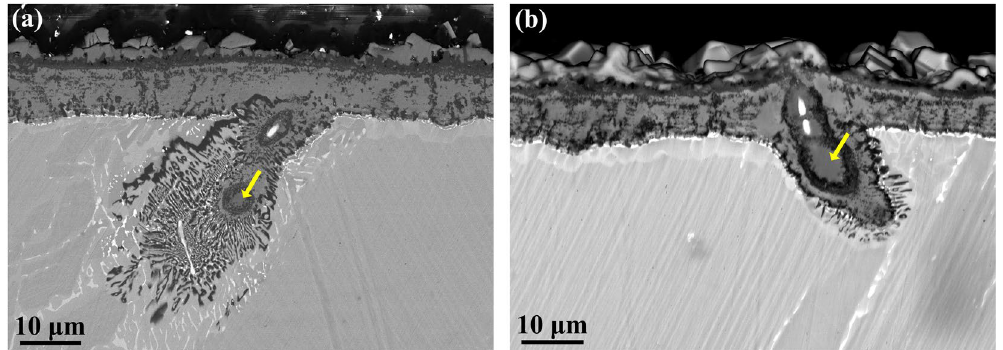
Figure 4. Typical micrographs showing transient core-shell globular oxides in TiAlNbCr alloy after oxidation at 900 °C for 100 h. ( a ) and ( b ) Morphologies of two oxides with a transient or incomplete core-shell globular structure at an intermediate distance to the scale-substrate interface.